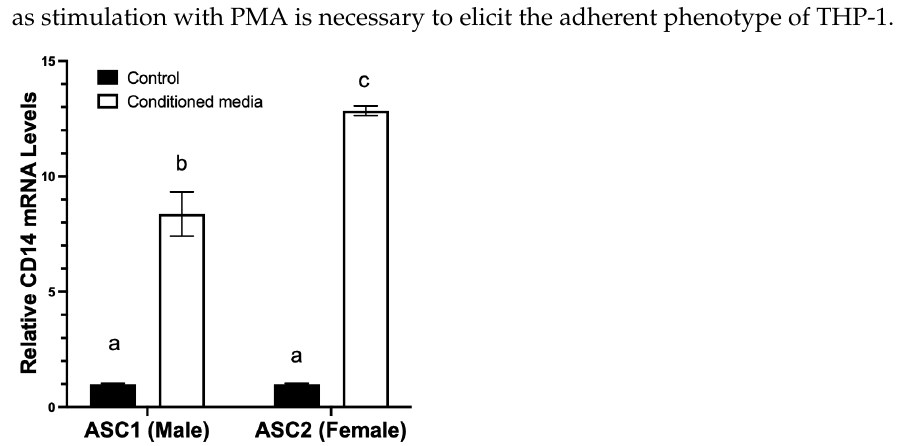
Figure 5. Effects of ASC-derived conditioned media on THP-1 cell differentiation. ASC-conditioned media were harvested as described in Materials and Methods. Human monocytic THP-1 cells were cultured in ASC-derived conditioned media for 48 h as described in Material and Methods. Cells were then harvested and total RNA isolated for determination of differentiation maker CD14 mRNA levels as described in Materials and Methods. Results are expressed as relative mRNA levels (Mean +/ − SD, n = 3) to control media. Black bar: control media. White bar: conditioned media. Bars with different letters indicate significant differences at p < 0.05.